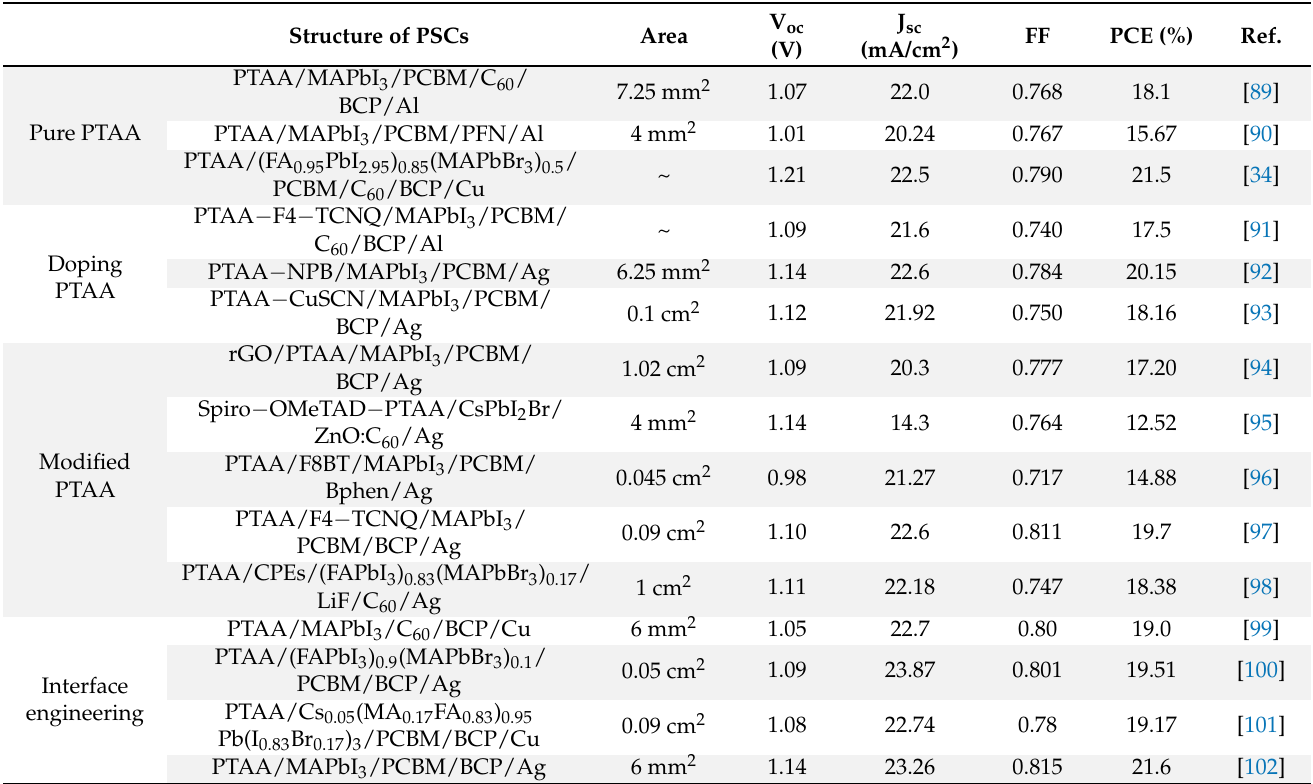
Table 6. Performances of several representative inverted PSCs on the basis of the PTAA materials with different structures. Structure of